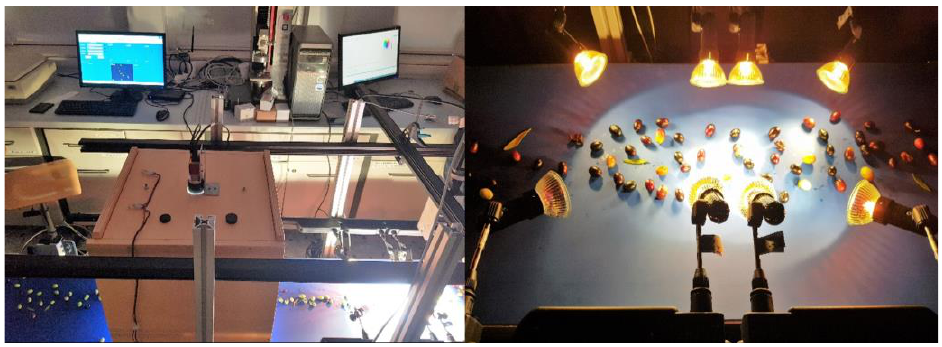
Figure 2. A pilot conveyor belt used to select